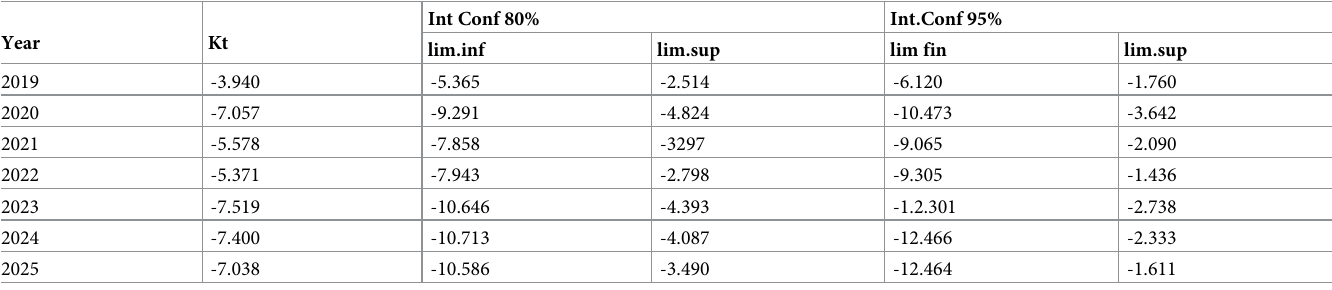
Table 9. k t estimated for both sexes (2019–2025) by the ARIMA model (2, 2,